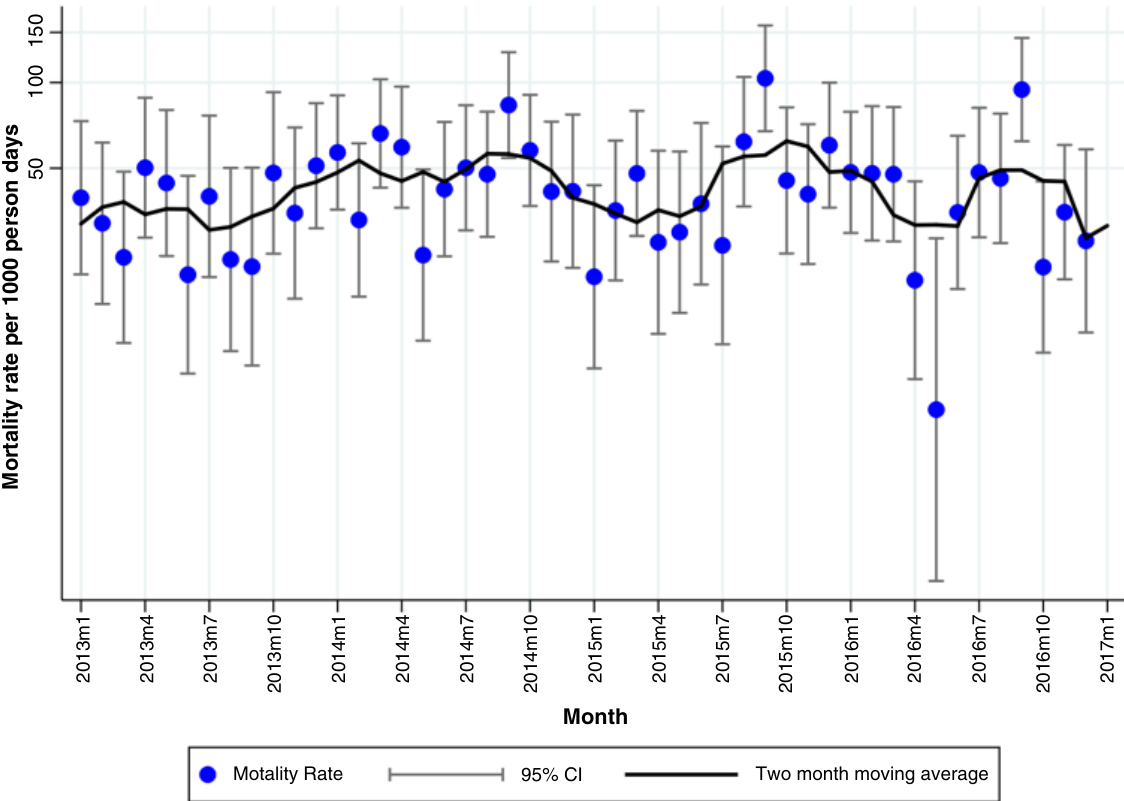
Figure 2. Monthly mortality rate (per 1,000-person days) and a 95% confidence interval and two months moving average smoothed morality rates for